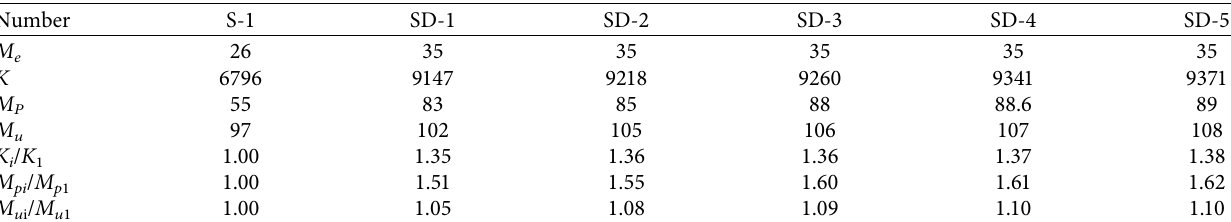
Figure 21: Moment-rotation curves of seat angle steel Table 11: Effect of seat angle steel on joint.